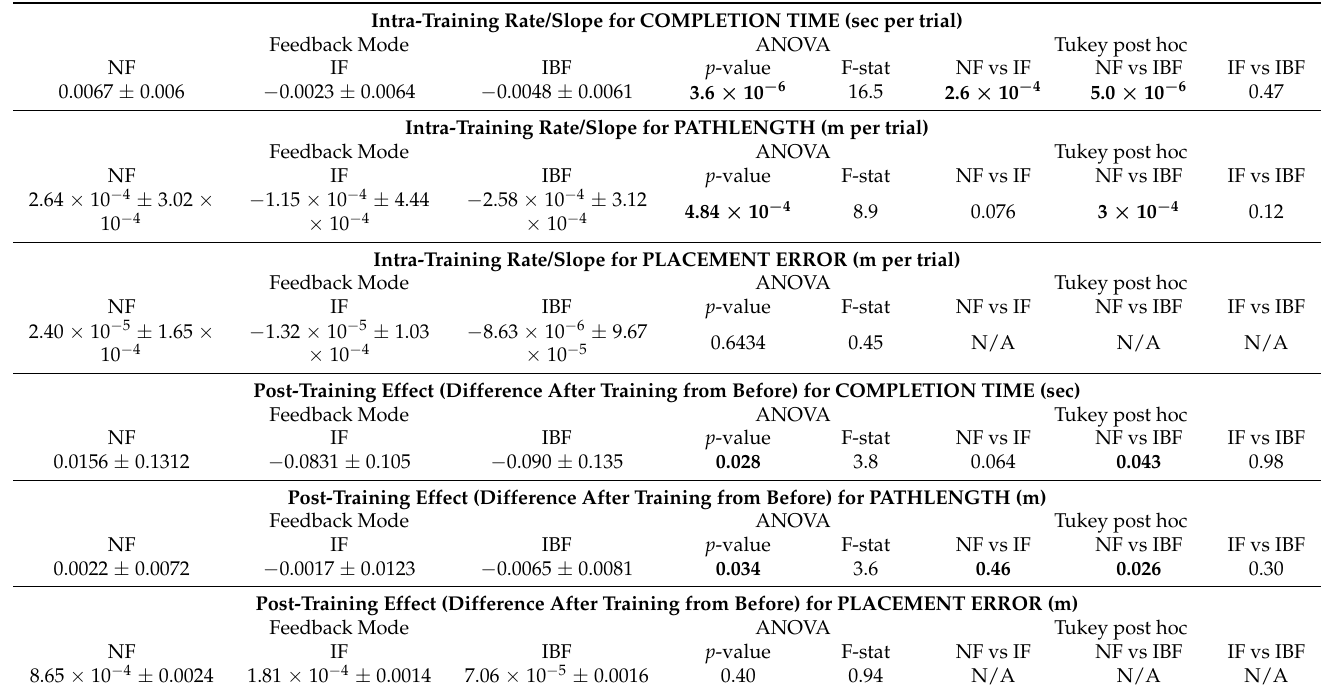
Figure 5. Example of linear regression fits to performance data of a single metric (completion time) shown across thirty sequential training trials for each of three feedback training conditions. Each ‘case’ represents the same subject with a distinct combination in trends of the regression slopes, i.e., intra-training rates. A ‘positive’ (desirable) intra-training rate is a decline in the performance metric value, i.e., slope < 0. Note: Training feedback groups: NF = No Feedback, IF = Immediate Feedback, IBF = Intentional Binding Feedback Table 4. ANOVA for intra- and post-training performance outcomes between training conditions (feedback modes). Feedback Modes: NF = No Feedback, IF = Immediate Feedback, IBF = Intentional Binding